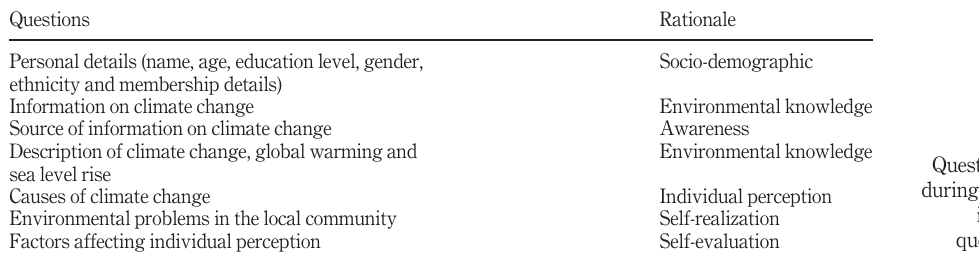
Table 1. Questions